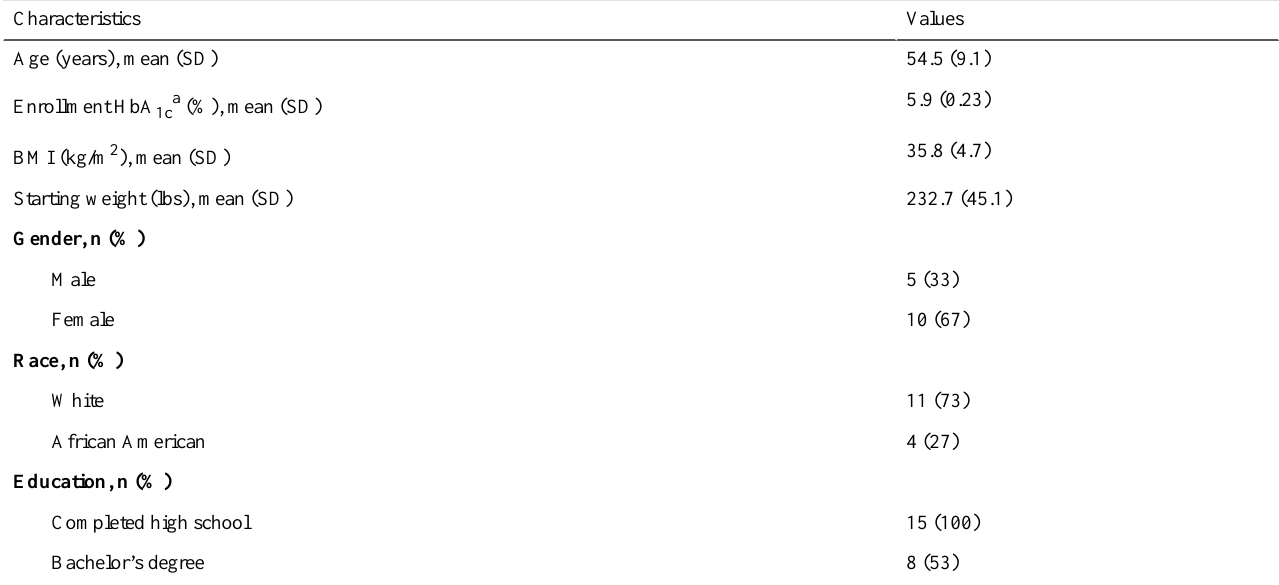
Table 1. Participant demographics of the pilot feasibility study (N=15).